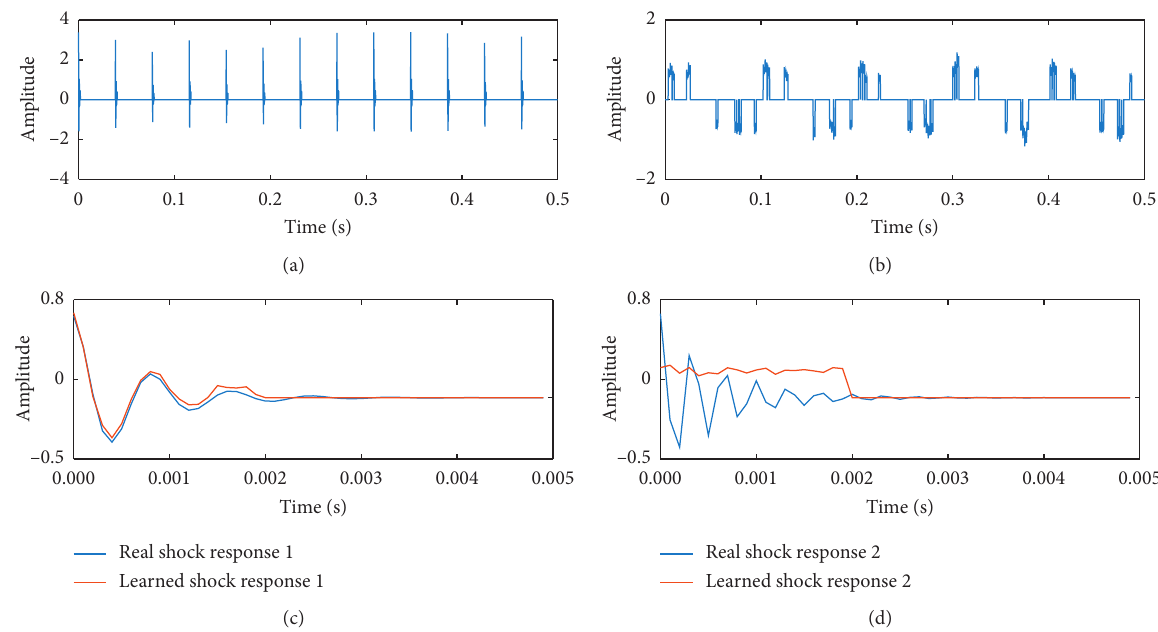
Figure 15: Processing results obtained using UC-DLA. (a) Reconstruction impulses corresponding to the learned shock response 1; (b) reconstruction impulses corresponding to the learned shock response 2; (c) learned shock response 1; and (d) learned shock response 2.